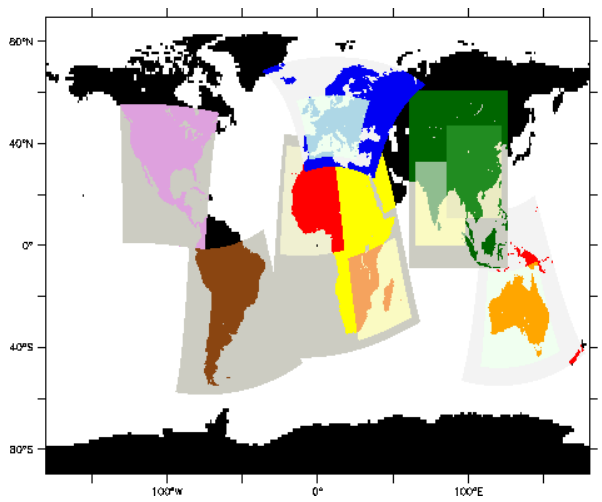
Fig. 1. Example for a MECO(n) model cascade setup using 13 in- stances (1 ECHAM/MESSy, n = 12 COSMO/MESSy